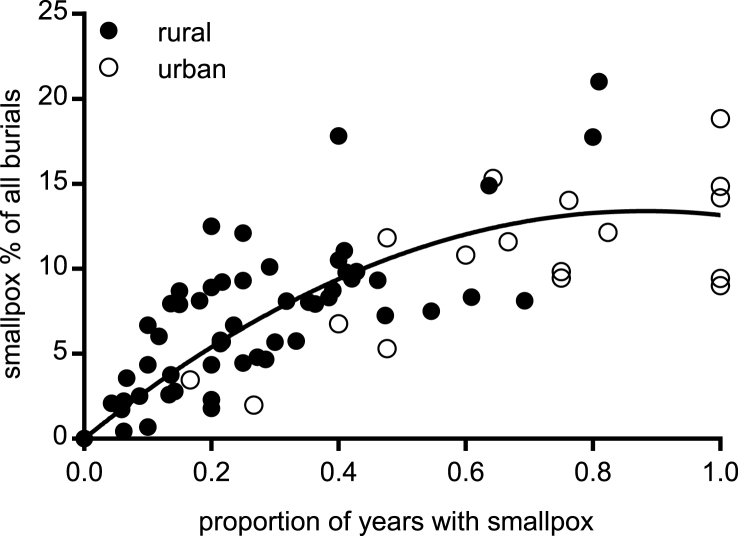
Smallpox burials percent of all burials and proportion of all years that smallpox burials were recorded. Values were fitted with a second order polynomial equation (r2 = 0.55, N = 72).